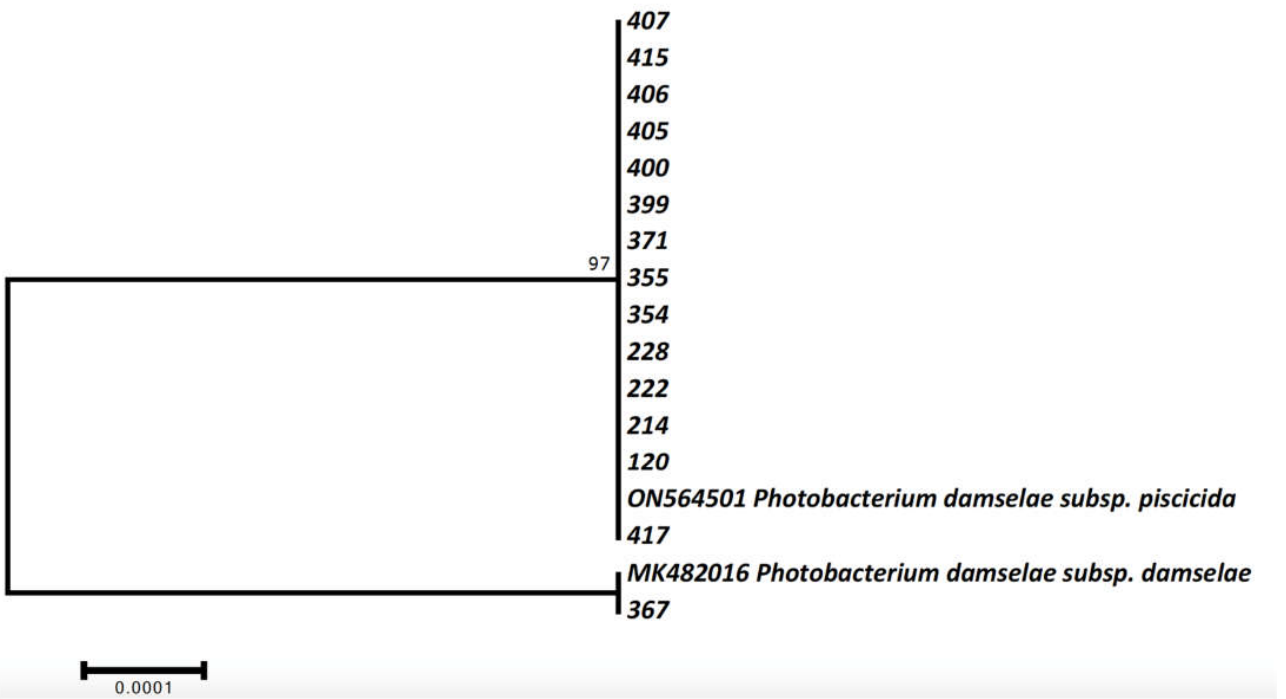
Figure 4. Maximum likelihood phylogenetic tree of the cultured bacteria strains. Codes as in Table 1.